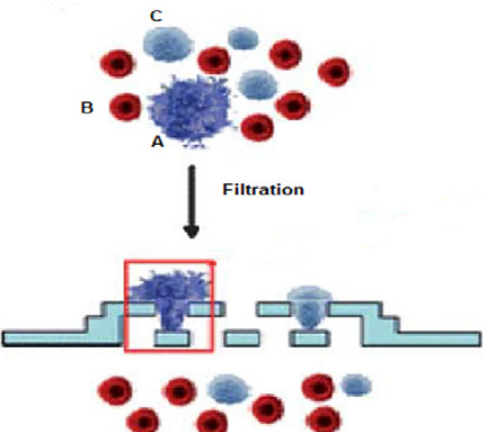
Fig. 2. Screening of Cancer Cells by Polymers; A) Cancer Cells, B) Red Cells, and C) White